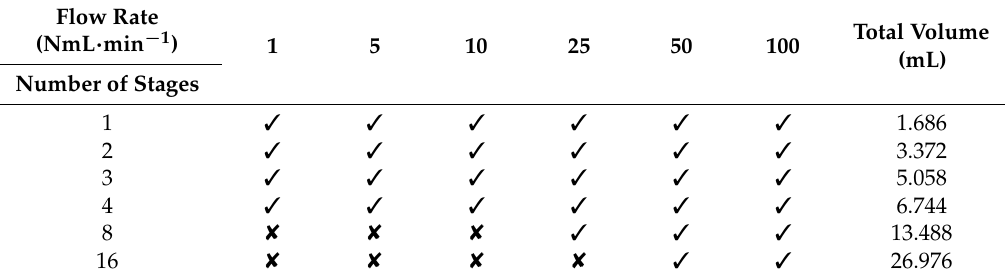
Table 3. Presentation of the simulations realized at different flow rates varying between 1 and 100 NmL · min − 1 and numbers of stages in the range 1–16. Configurations marked with a (cid:51) have been simulated, while configurations marked with a (cid:56) have not been studied. The total microfluidic circuit volume of the stages set is also calculated and mentioned on the